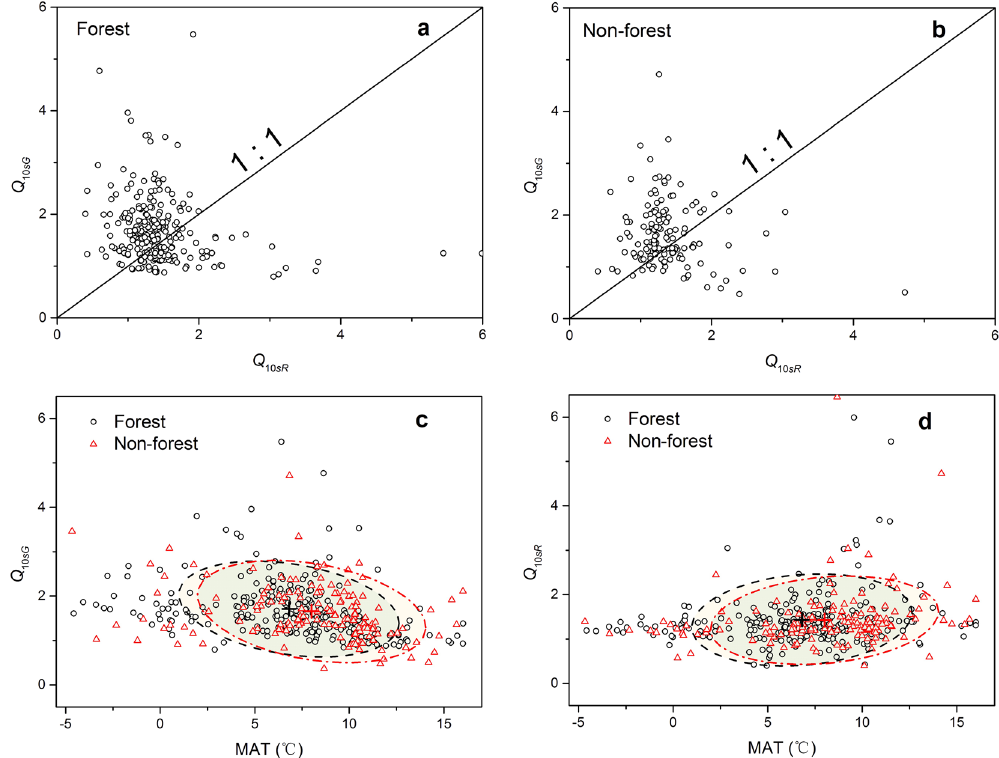
Figure 4. The intrinsic temperature sensitivity of gross primary production rate ( Q 10 sG ) vs. that of respiration rate ( Q 10 sR ) in ecosystems with plant function types in ( a ) the forest site group and ( b ) the non-forest site group, and changes of ( c ) Q 10 sG and ( d ) Q 10 sR with the mean annual temperature (MAT) in the two plant groups. The forest site group includes deciduous broadleaf forest, evergreen needleleaf forest, and mixed forest. The non- forest site group includes croplands, closed shrublands, grasslands, open shrublands, and permanent wetland. The confidence ellipses in ( c , d ) were derived at the level of one standard deviation of probability distribution and the symbol “ + ” indicates the center of